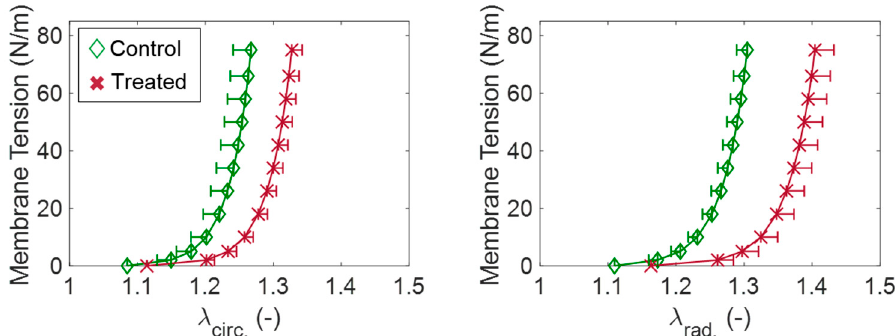
Figure 10. Mean ± SEM ( n = 6) of the membrane tension versus total tissue stretch results ( left : circumferential direction, right : radial direction) for the TVAL between the control and enzyme-treated groups under equibiaxial loading ( F x : F y = 1:1). Figures were modified from Ross et al . (2019) [145].